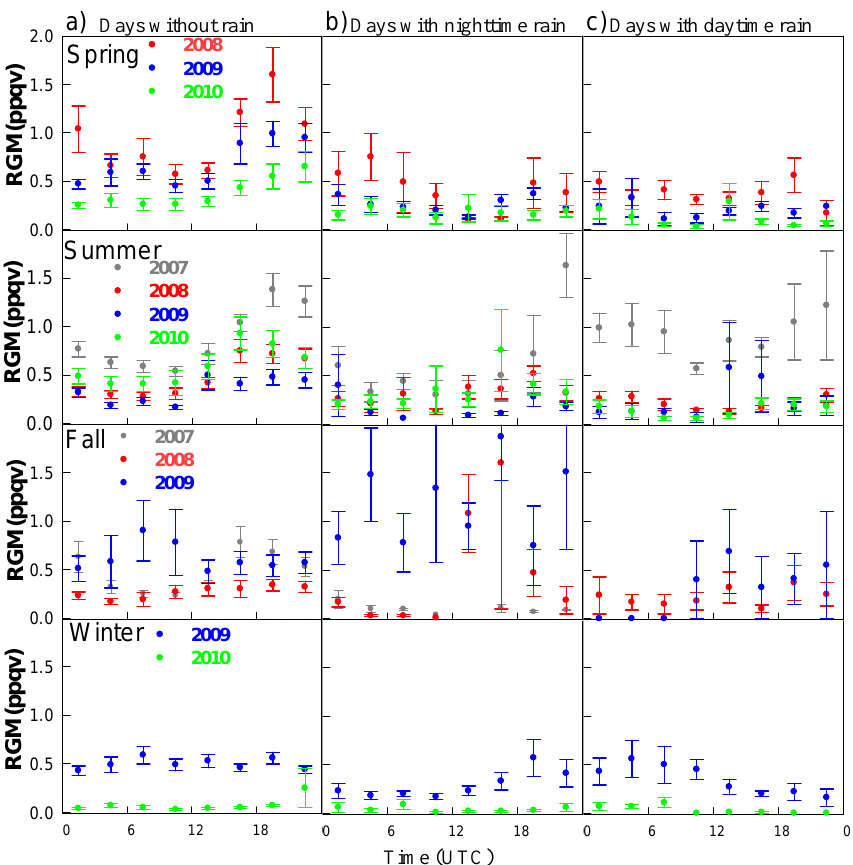
Fig. 17. Diurnal cycles of RGM at AI (marine) averaged over days without rain (a) , days with nighttime rain (b) , and days with daytime rain (c) for all seasons during 2007–2010. Precipitation in winter includes rain and snow. Local nighttime is about 00:00–11:00UTC, daytime 12:00–23:00UTC, and noontime is 16:00UTC during the Daylight Saving period of the year and 17:00UTC otherwise.